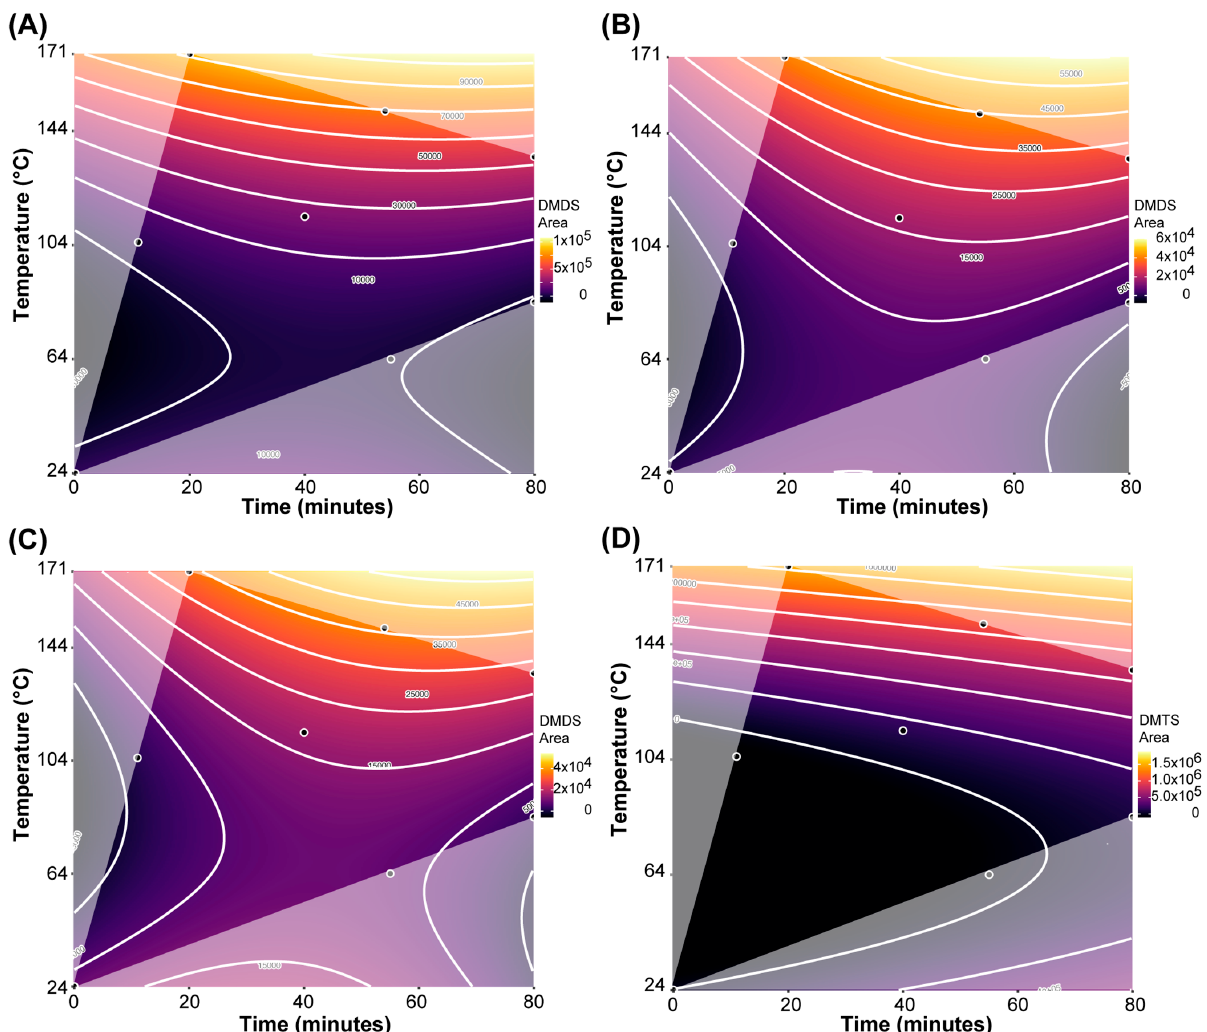
Figure 3. Response surface contour plots for dimethyl disulfide (DMDS) and dimethyl trisulfide (DMTS), as a function of roasting time and roasting temperature. ( A ) DMDS in samples from Ghana; ( B ) DMDS in samples from Madagascar; ( C ) DMDS in samples from Peru; ( D ) DMTS in samples across all three origins.